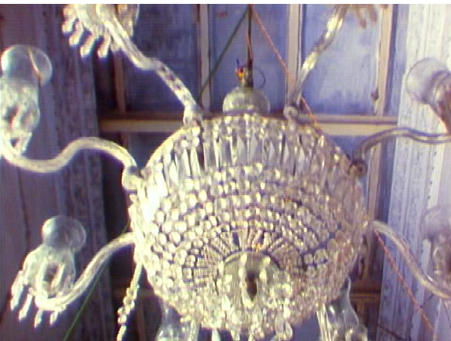
Figure 3. Chandelier from the opening sequence, screen grab, Utsab